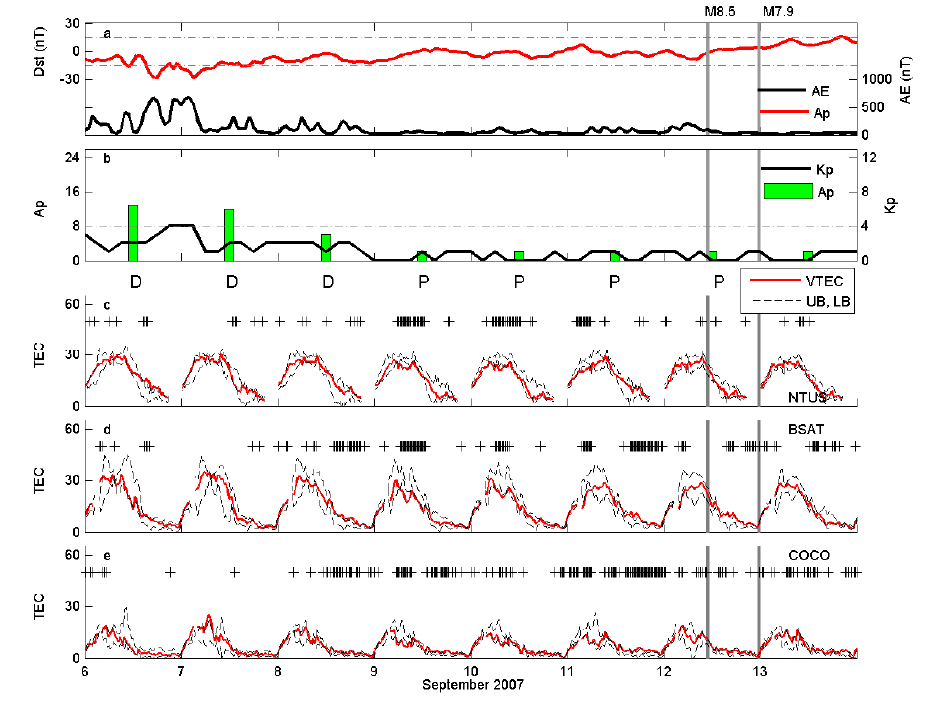
Fig. 9. The geomagnetic indices (a) Dst and AE, (b) Ap and Kp, and the (c-e) TEC variations and the associated upper and lower bounds between 6 and 13 September 2007 at 3 GPS stations.